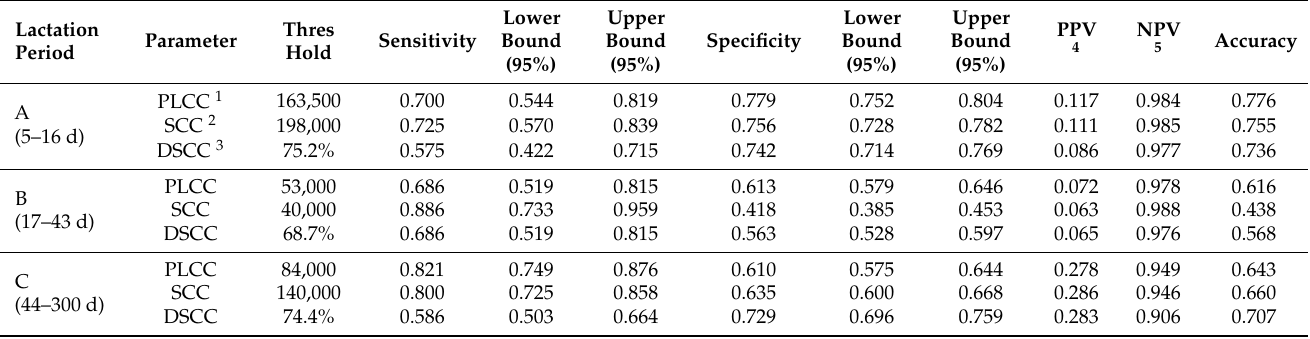
Table 3. Results of ROC analysis to identify the thresholds for the three cellular markers with the highest accuracy in identifying MajP classified for the three lactational periods